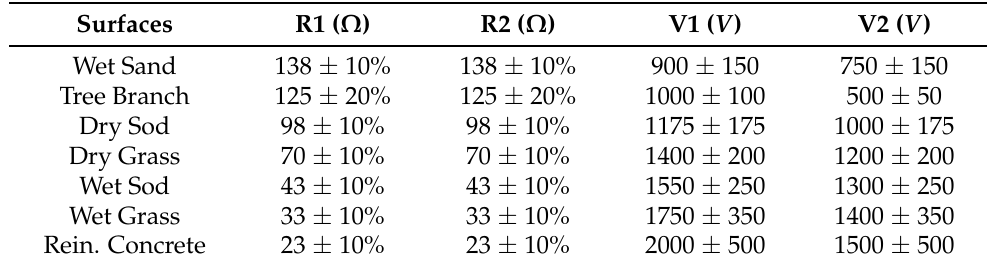
Table 1. HIF Model parameters For different